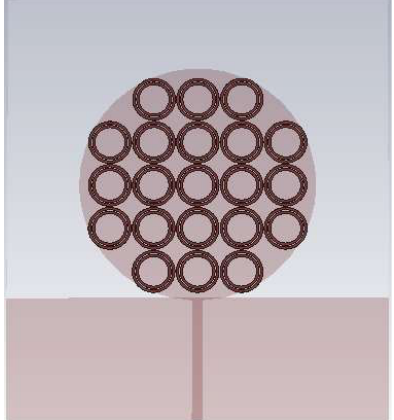
Figure 22: Patch loaded with CRR array.